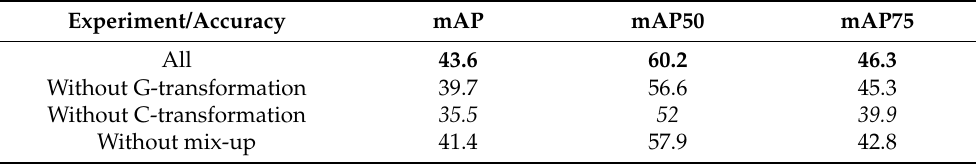
Table 5. The mAP values of different augmentation methods.